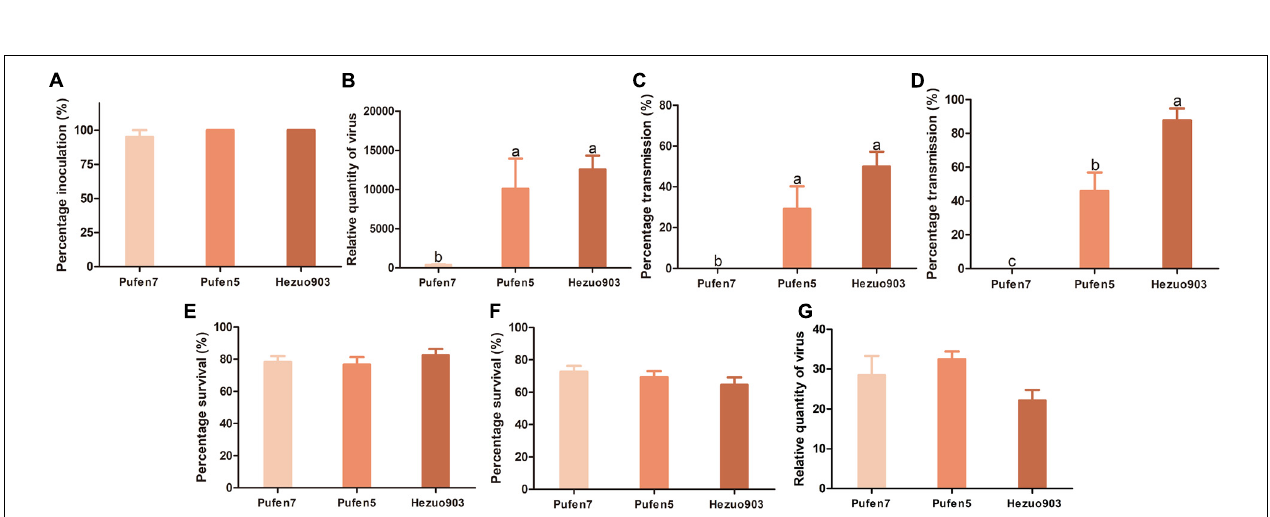
FIGURE 2 | Resistance to tomato yellow leaf curl virus (TYLCV) in plants of tomato cultivars Pufan7, Pufen5, and Hezuo903. (A) Percentage of TYLCV-infected plants in agro-inoculated plants; (B) Relative quantity of virus in agro-inoculated plants; (C) Percentage of TYLCV-infected plants in whitefly-inoculated plants when the durations of both virus acquisition and transmission were 48 h and five whiteflies were used per test plant; (D) Percentage of TYLCV-infected plants in whitefly-inoculated plants when the durations of both virus acquisition and transmission were 96 h and ten whiteflies were used per test plant; (E) Whitefly survival on plants when five whiteflies were used per test plant; (F) Whitefly survival on plants when ten whiteflies were used per test plant; (G) Relative quantity of virus in whiteflies recovered from plants post virus transmission when 10 whiteflies were used per test plant. Values are means ± SEM ( n = 3 for panels (A,C,D) and in each replicate 7–8 plants were used; n = 14 for panel (B) ; n = 24 for panels (E,F) ; n = 4 for panel (G) ]. Different letters above the columns indicate significant differences (one-way ANOVA, p < 0.05).